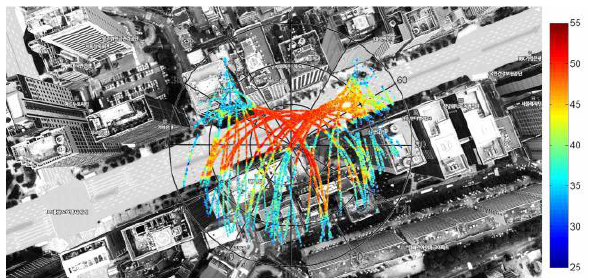
Figure 9. Overlapped result of signal strength sky-plot and 3D model (Kim et al.,